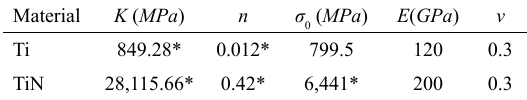
Table 3. Mechanical properties of Ti and TiN . 1, 32